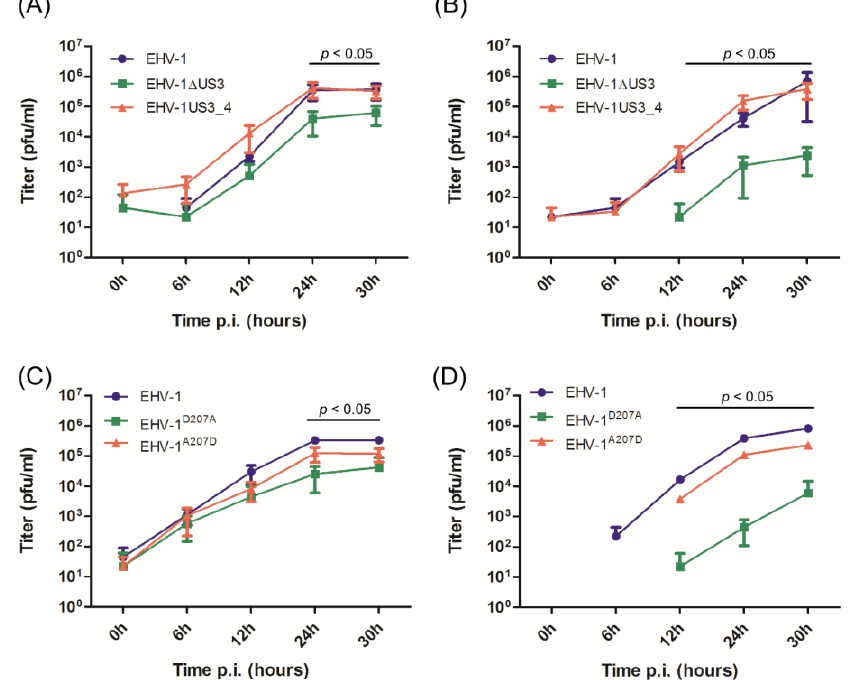
Figure 2. Growth properties of mutant and recombinant viruses. Confluent equine dermal (ED) cells were infected with the different viruses as indicated in the figure. Infected cells ( A and C ) and supernatant ( B and D ) were collected separately at different time points post-infection (p.i.; 0, 6, 12, 24 and 30 h) and virus titers were determined. The data presented are means ± standard deviations (SD) of three independent experiments. Significance levels ( p < 0.05) were determined for US3 -deleted